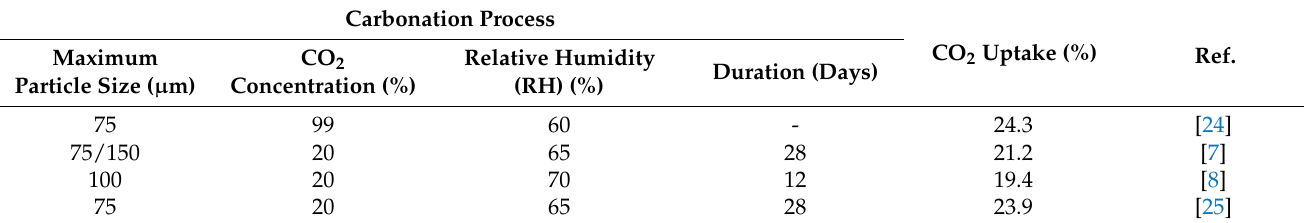
Table 1. Carbonation process experiments reported in the literature (at 20 ◦ C and for a CO 2 pressure of 1 atm). Carbonation